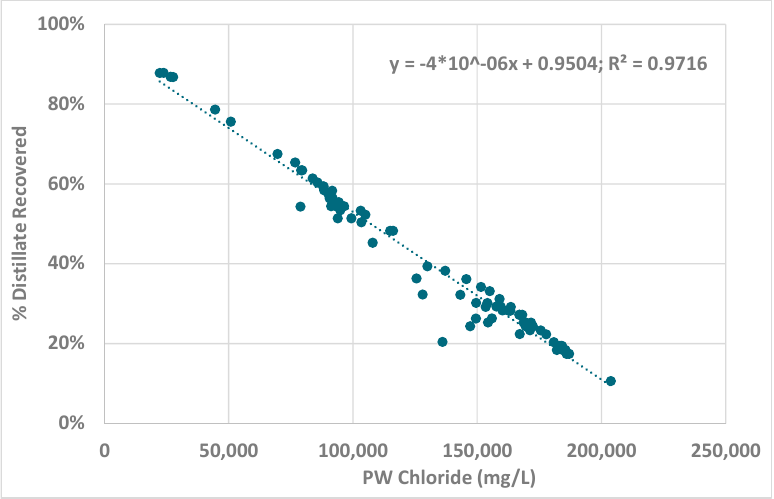
Figure 3. Modelled distillate recovery as a function of PW Chloride using an MLD approach.